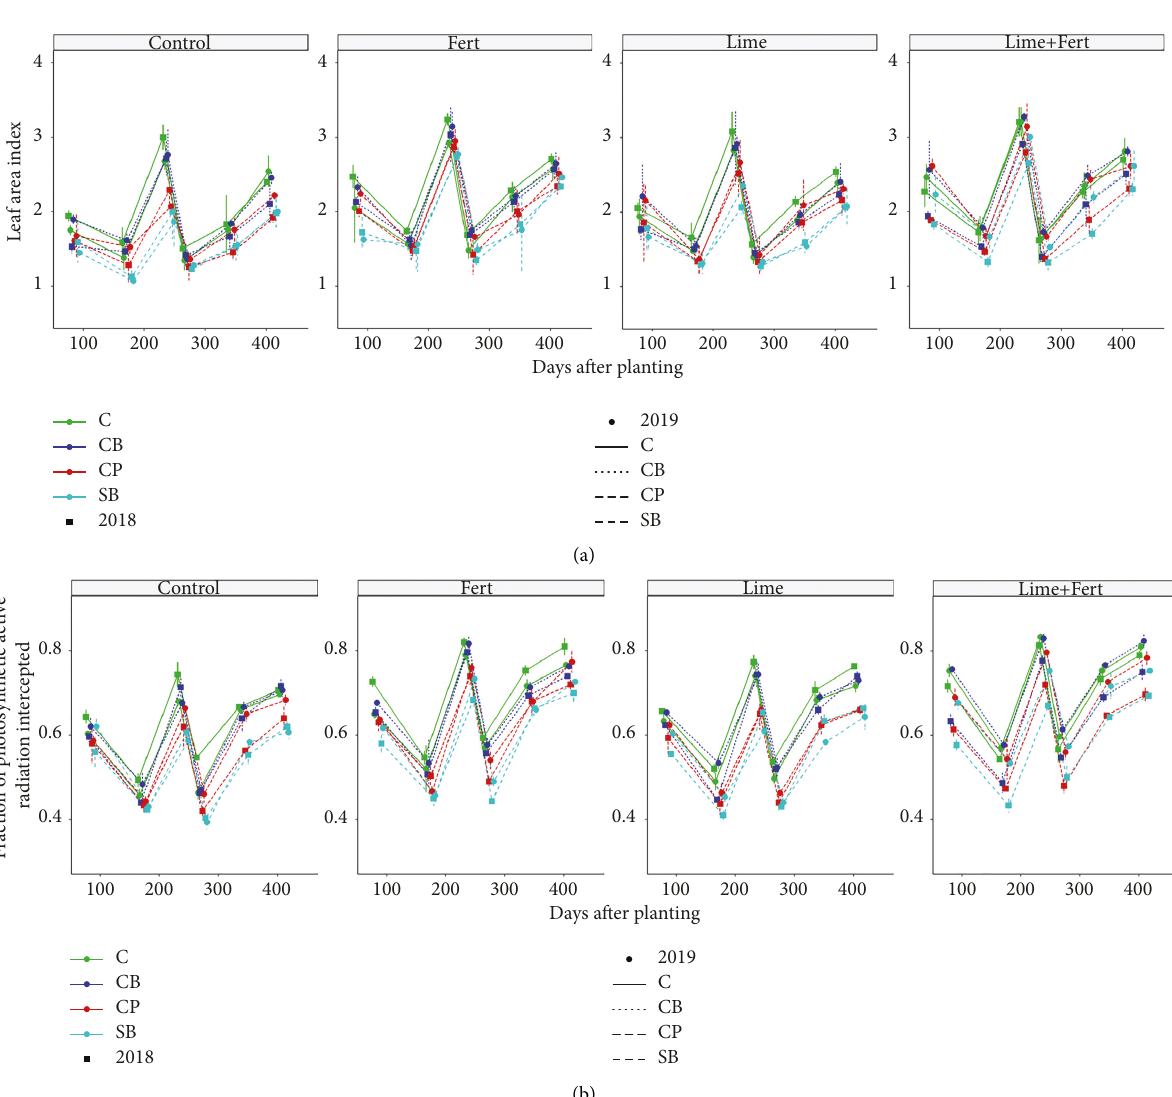
Figure 2: Effects of intercropping soybean (SB), beans (CB), and cowpea (CP) on the cassava leaf area index (LAI) and fraction of intercepted PAR under various fertilizer and lime rate in 2017–2018 and 2018–2019